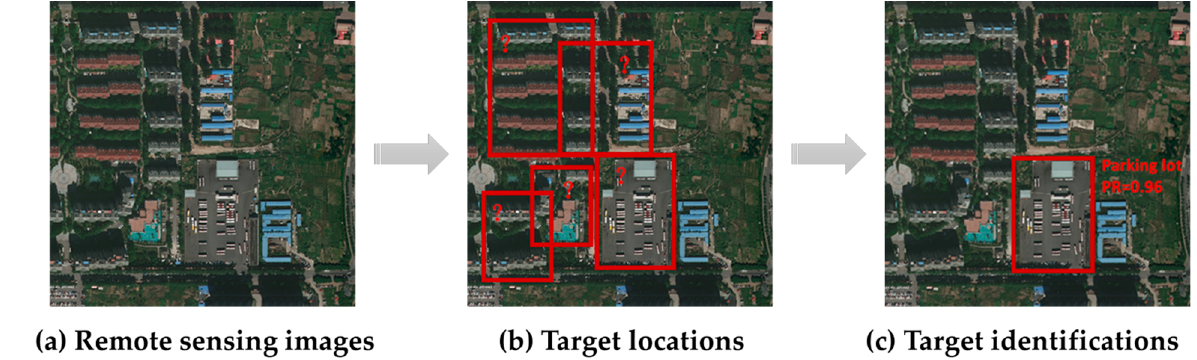
Figure 4. Target detection schematic. ( a ) is the original remote sensing image; ( b ) reflects that the candidate locations of the targets are found in the image; ( c ) reflects the results of target identifica- tions.